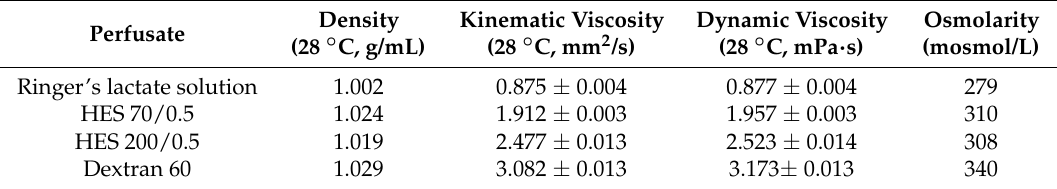
Table A1. Characteristics of the different crystalloid and colloid perfusates investigated; HES (hydroxyethyl starch).